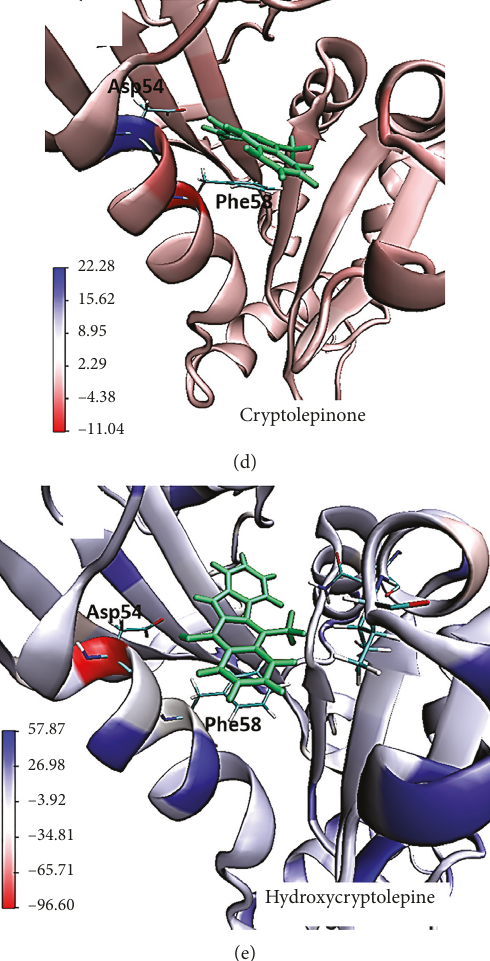
Figure 10: (a) Trajectory showing stability of protein ligand complexes for dm- Pf DHFR. Selected starting conformations were preserved with little deviations. RMSD converged at < 0.4nm, except that of cryptoheptine (RMSD � ∼ 1.0nm from 3ns to 50ns). A steady increase (0.4nm–1.0nm) in cryptolepinone RMSD was also observed between 35ns and 50ns, due to solvent accessibility. Interacting residues contributing to binding affinity have been colored based on b-factors (b–e). Val45, Leu46, Met55, Phe58, Ser111, and Ile112 favorably interacted with ligands of both classes, except hydroxycryptolepine (e). Hydrogen bonding with Asp54 recorded highest occupancy and residual contribution to binding (red colour; − 96.60 kJol/mol), hence overall complex stability (grey to blue). Loop regions exhibited high b- factors when involved in ligand binding